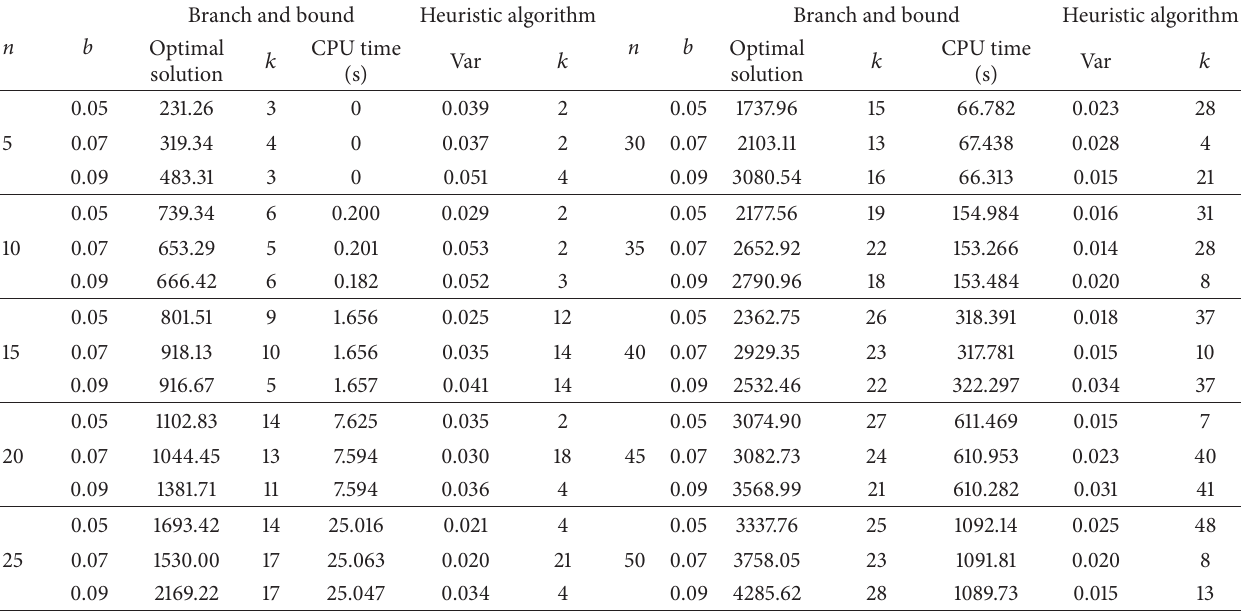
Table 1: Comparison of results from B & B; HA for 1|𝑝 𝑖𝑟 , rm |𝐶 max .